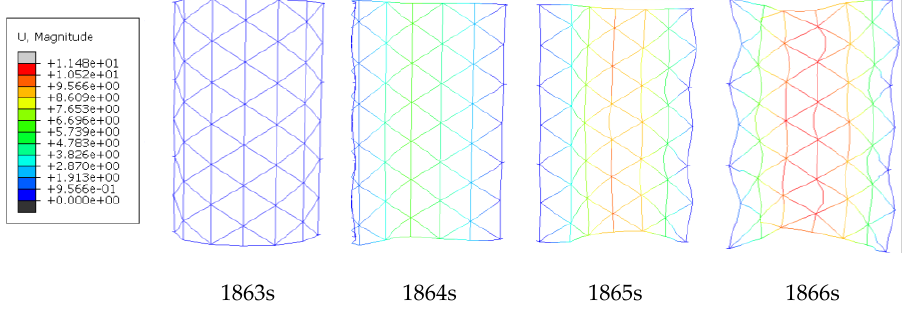
Figure 17. Structural deformation under fire location I.